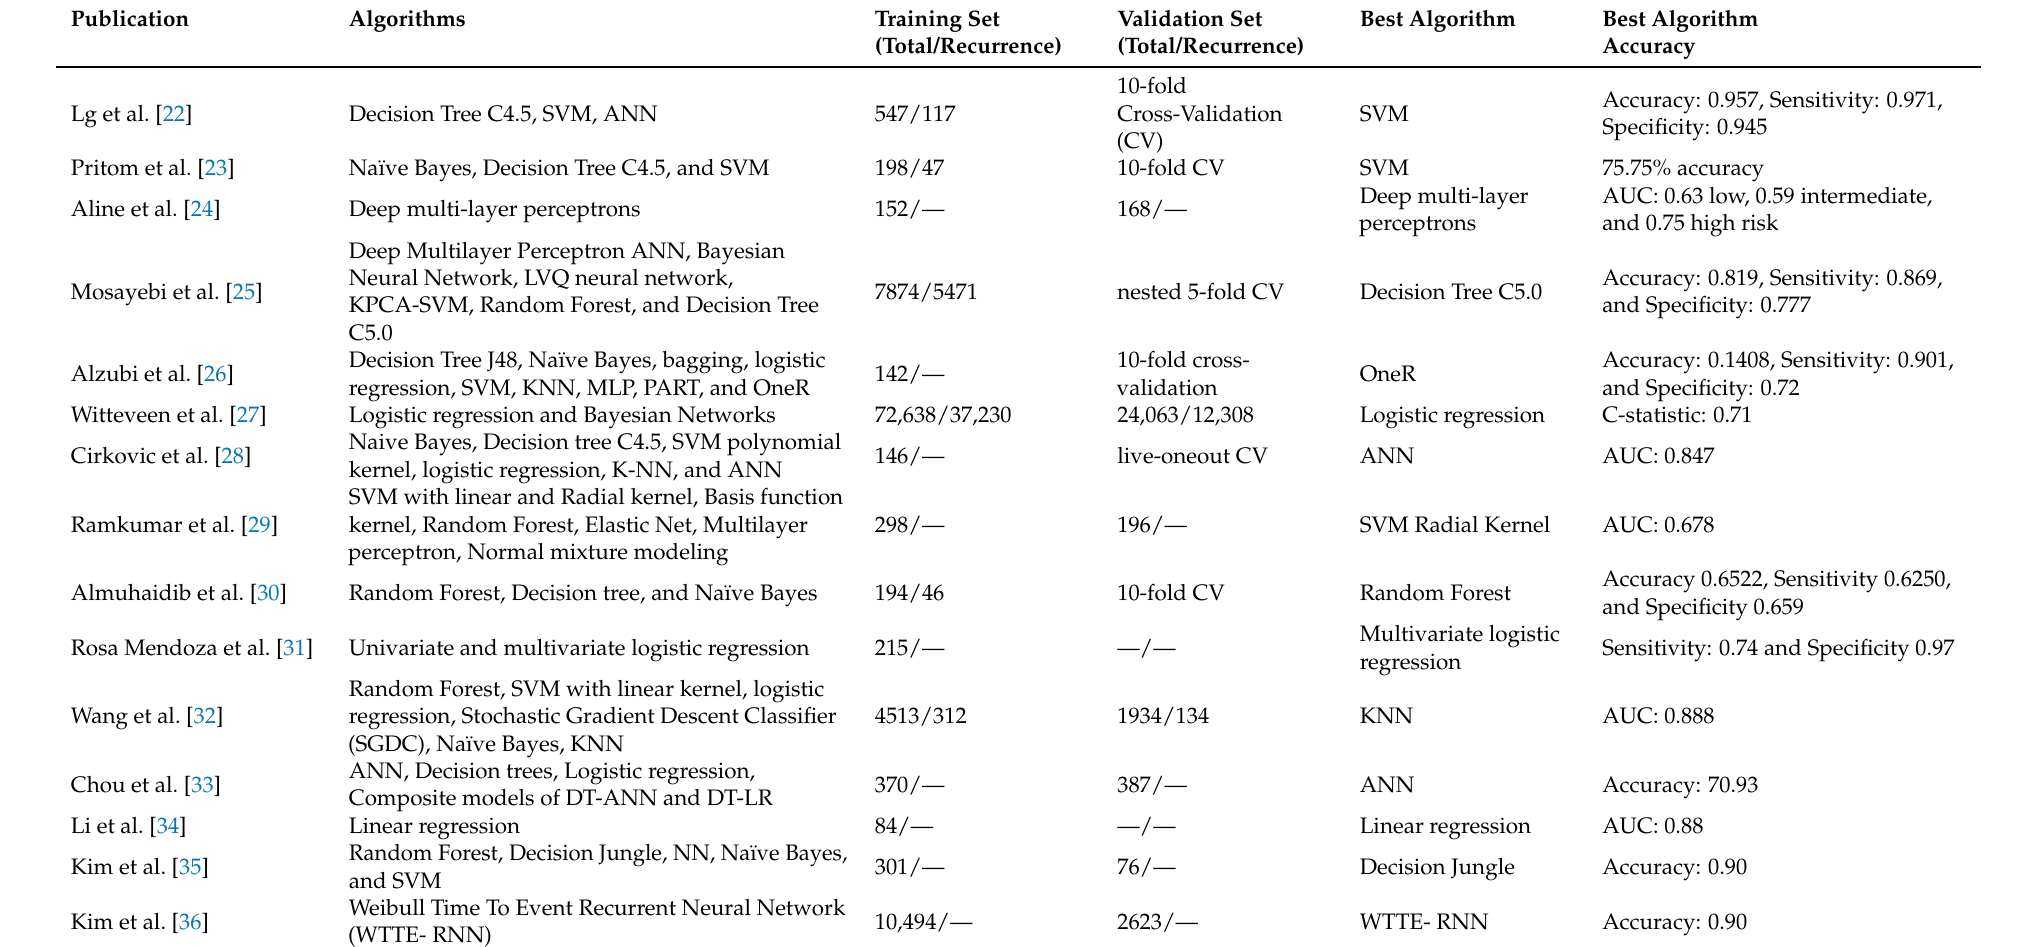
Table 2. Table showing the use of artificial intelligence algorithms in papers included in our